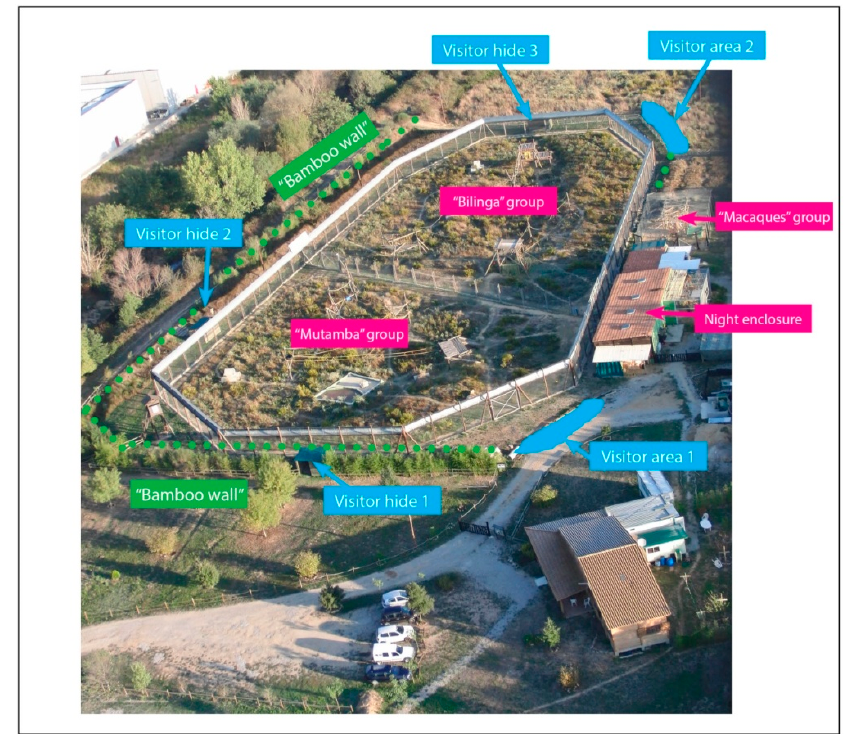
Figure 1. View of the animal facilities and visitor areas at Fundació Mona: Animal habitats labelled in pink; Visitor viewpoints labelled in blue ; Bamboo visibility block labelled in green.